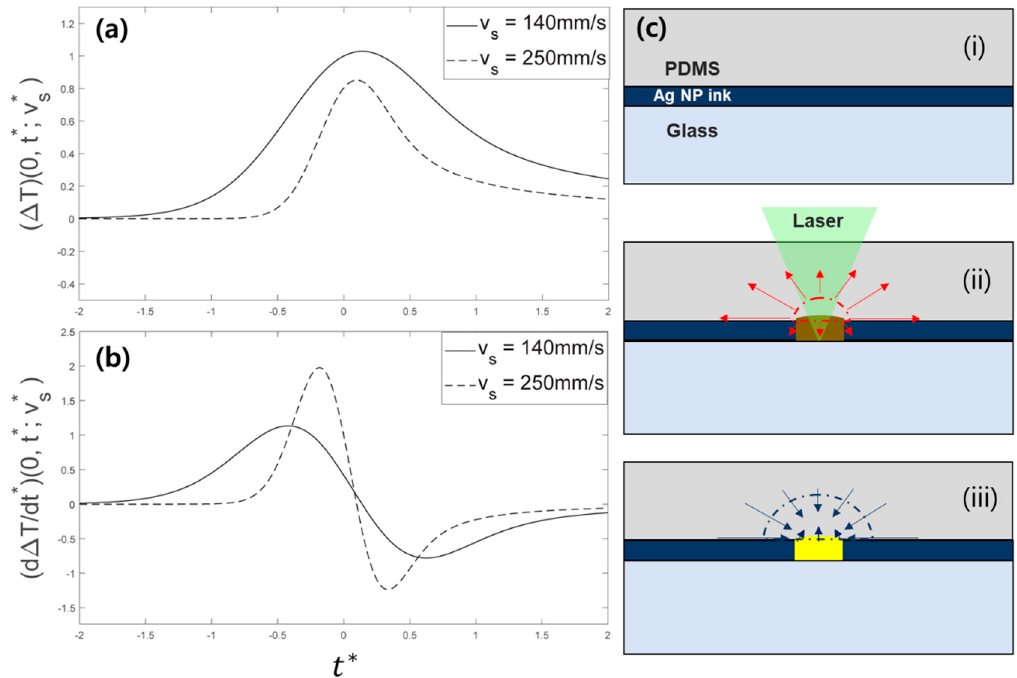
Figure 4. Laser-induced ( a ) temperature increase and ( b ) its gradient observed at a fixed point on the scanning path calculated from the heat equation for two different scanning speeds of 140 mm/s and 250 mm/s; ( c ) Schematics for the laser transfer mechanism: ( i ) Cross-sectional configuration of the system under concern; ( ii ) Laser-induced temperature increase initiates the sintering as well as the expansion of the PDMS layer; ( iii ) Subsequent cooling step causes contraction of the PDMS layer that assists the transfer of the sintered Ag